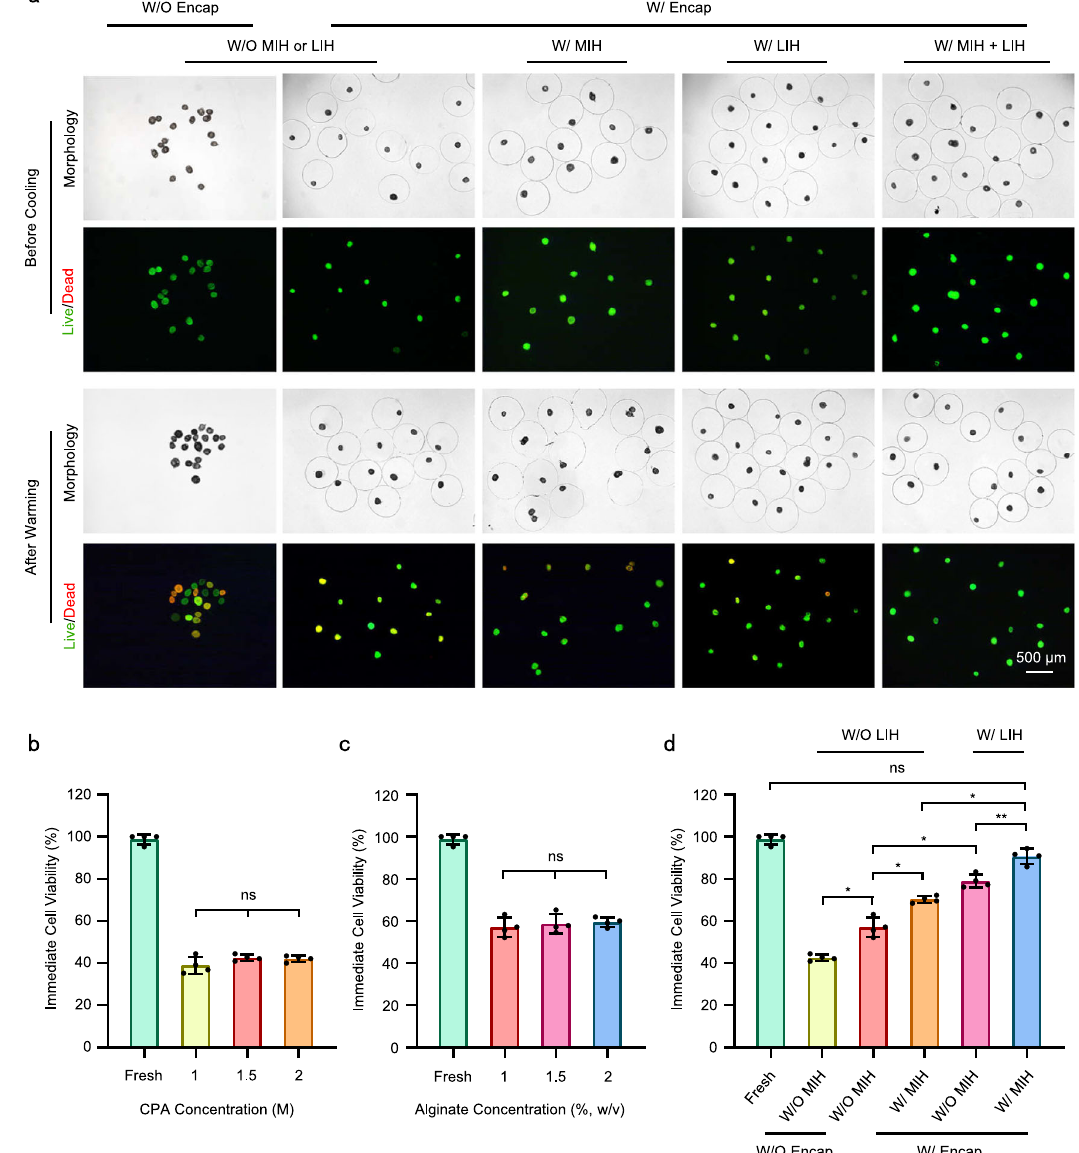
Fig.3|EffectofMIHandLIHonPAFsduringwarming.a Differentialinterference contrast (DIC) and fl uorescenceimages of PAFs after warming under the following different conditions: W/ Encap or W/O Encap, W/ LIH, W/ MIH or W/ MIH and LIH during warming. b Viability of the PAFs after vitri fi cation with different CPAs (0M, green;1M,lightgreen;1.5M,orange;2M,purplebars). P 1 – 1.5 =0.5978, P 1 – 2 =0.4151, P 1.5 – 2 =0.9785. Each experiment was repeated three times with similar results, and representative images are shown. c Viability of the PAFs encapsulated in different concentrationsofalginatehydrogel(0%,green;1%,rust;1.5%,pink;and2%,emerald green bars. w/v) after vitri fi cation with different 1.5M CPA. P 1 – 1.5